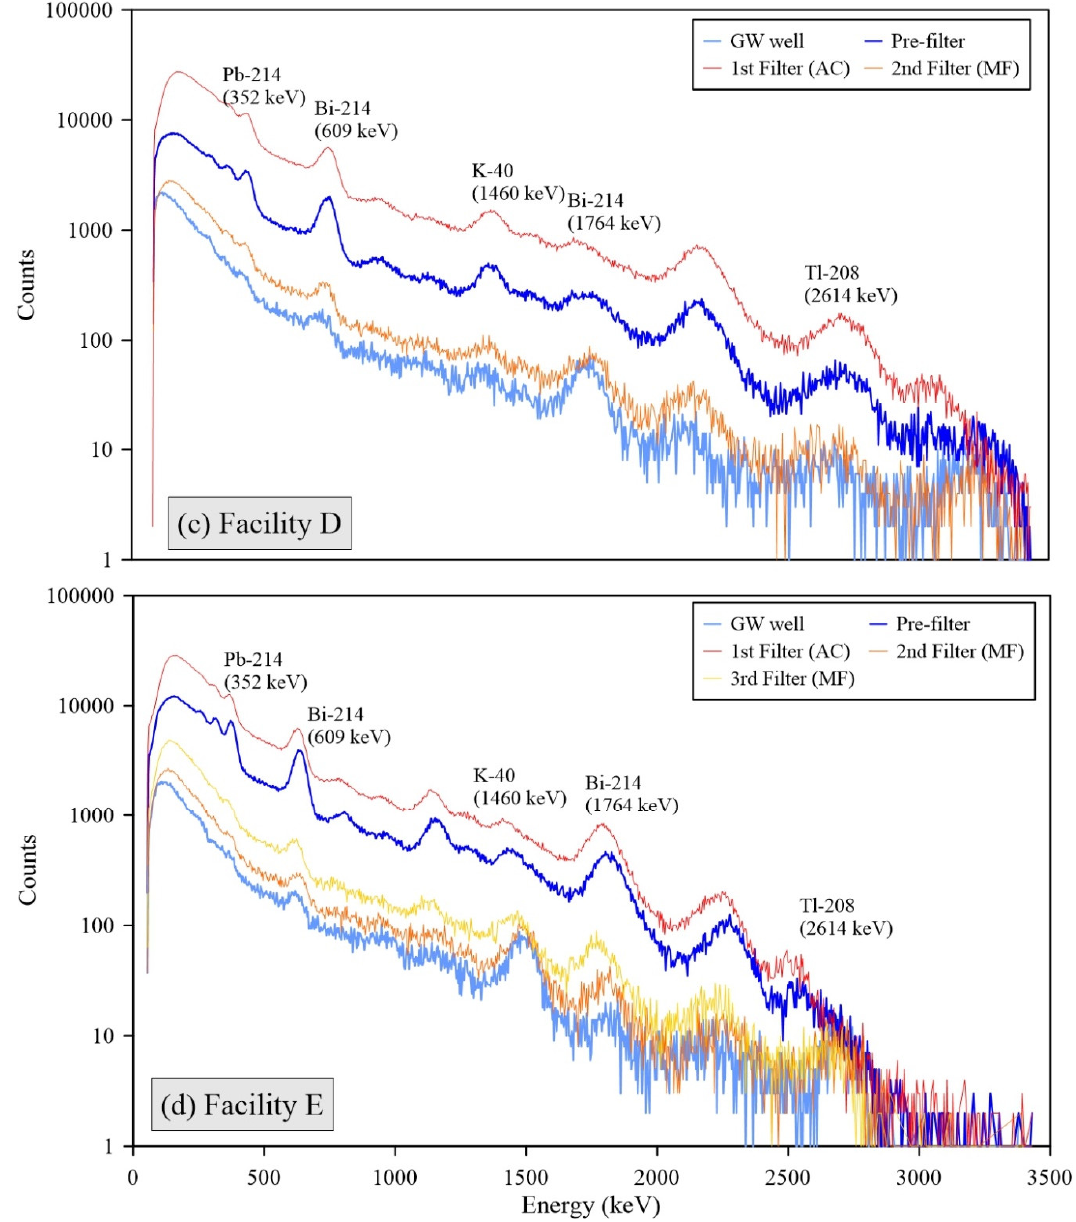
Figure 3. Spectra of radiation measured at the surface of individual filtering units: ( a ) Facility B, ( b ) Facility C, ( c ) Facility D, and ( d ) Facility E.